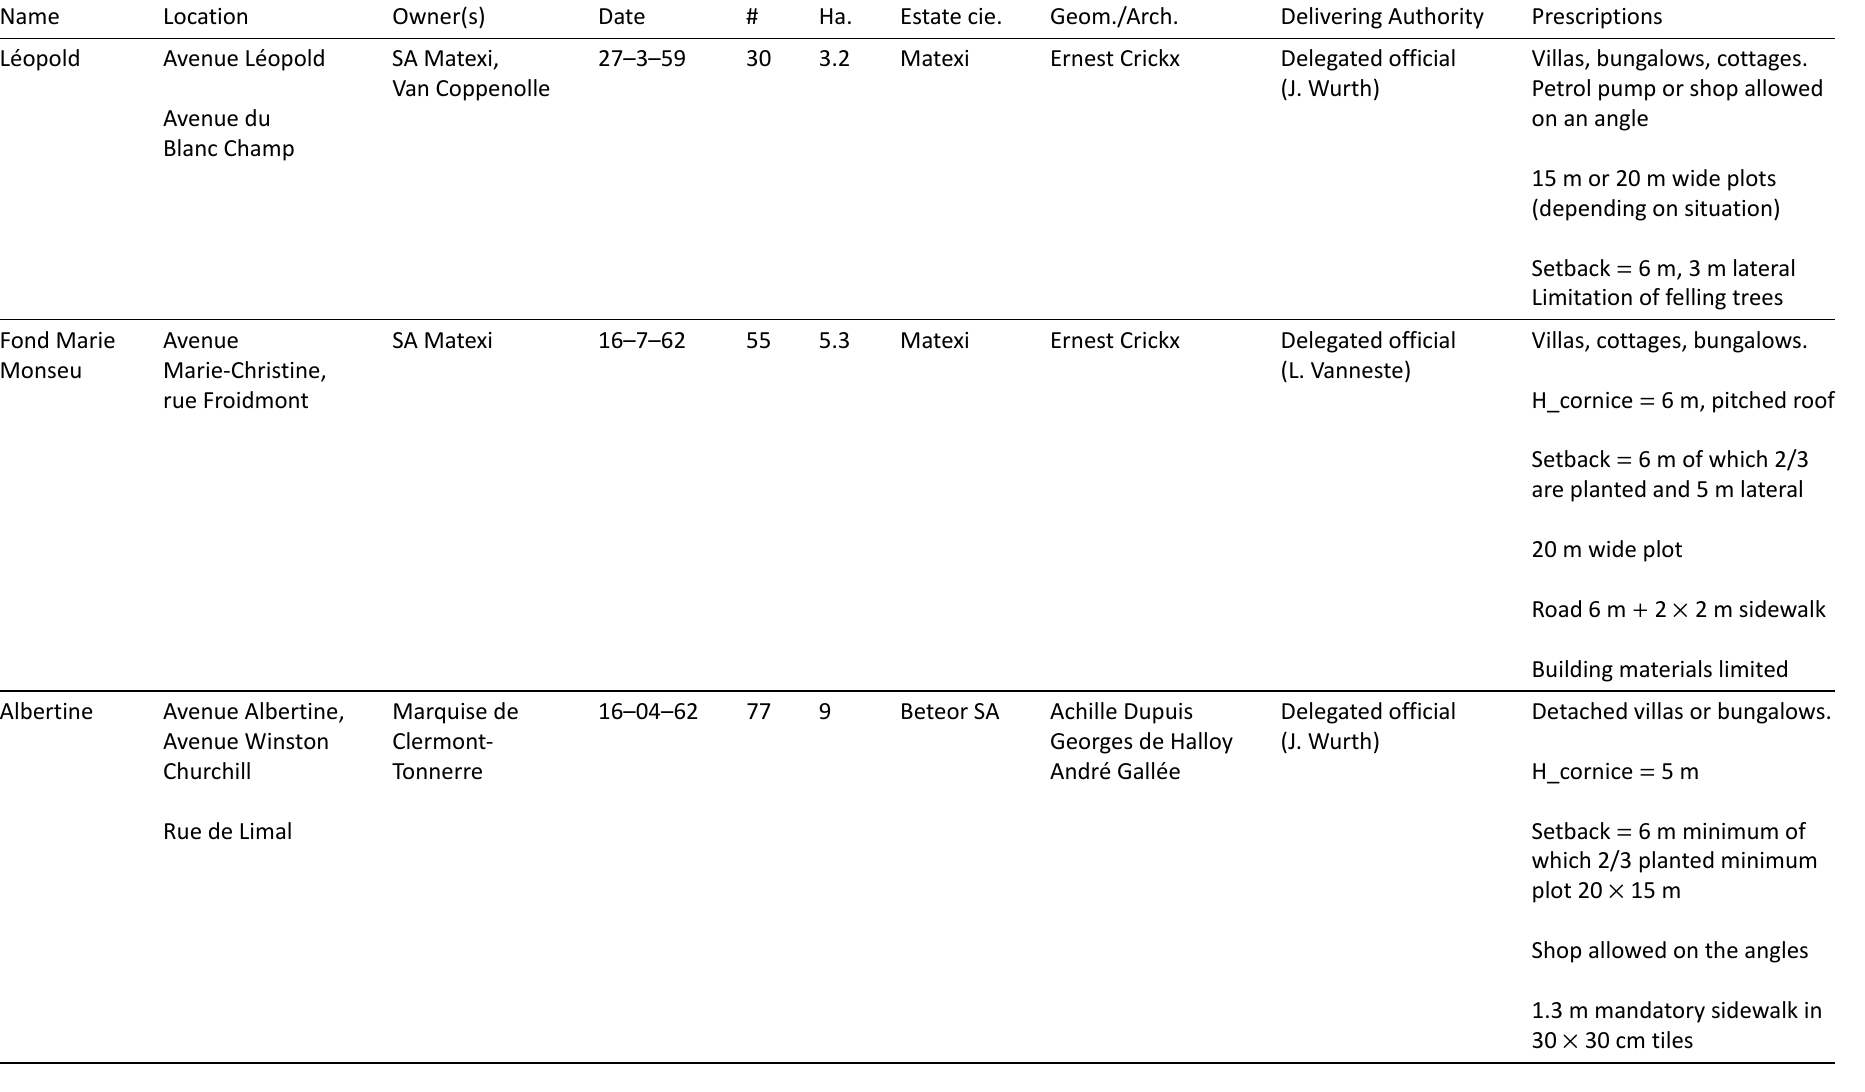
Table 2. Selection of allotments in